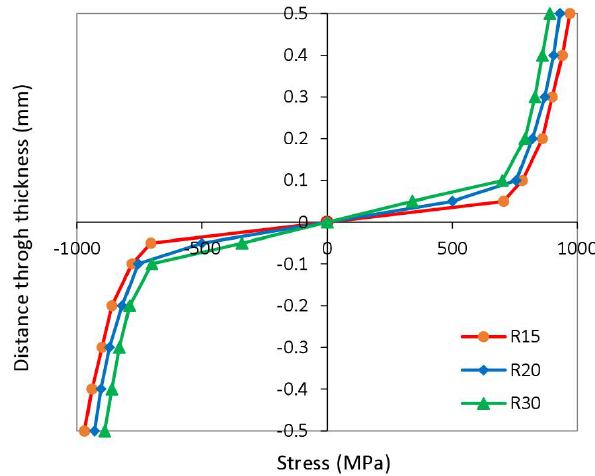
Figure 12. Through-thickness stress distributions in curved speci-